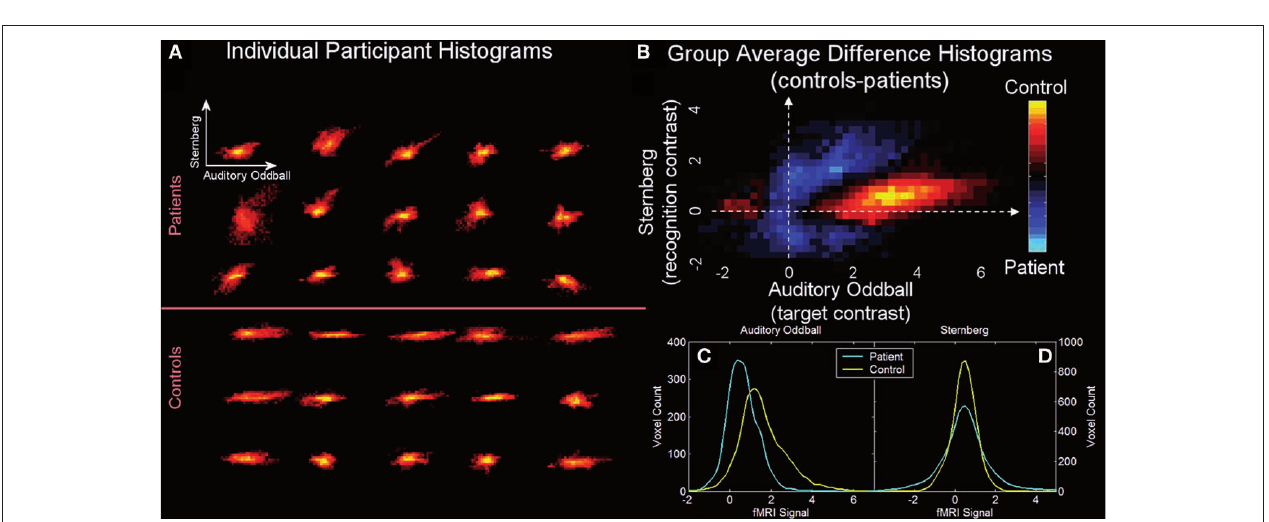
FIGURE 4 | Cross-task 2D histograms for AOD versus SB fMRI activation (from Calhoun et al., 2006b). Joint 2D histograms for voxels identifi ed in the analysis. Individual (A) and group average difference (B) histograms (with orange